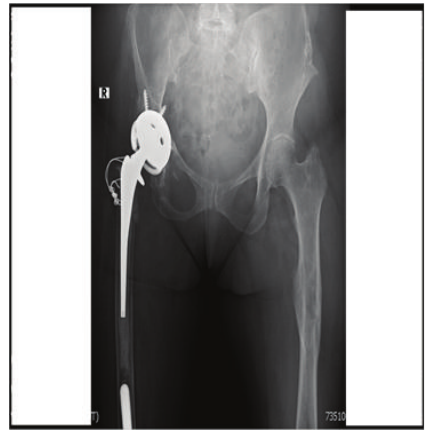
Figure 9: 3 months after operation.